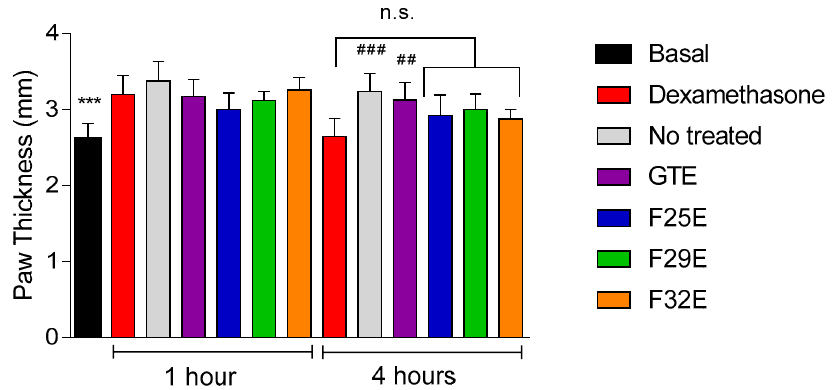
Figure 7. Anti-inflammatory activity of the LCS with green tea extract at 300 mg·g − 1 (F25E, F29E, and F32E), dexamethasone (positive control—cream containing dexamethasone at 1 mg·g − 1 ), and negative control. Notes: the data are represented as mean ± standard deviation of results from five mice. The statistical significance of paw thickness was analyzed using variance analysis via Dunnett’s multiple comparison test; *** p ≤ 0.001. vs. Dexamethasone at 1 h of experiment. ## p ≤ 0.01 vs. Dexamethasone at 4 h of experiment. ### p < 0.001 vs. Dexamethasone at 4 h of experiment. n.s.: no significant difference vs. Dexamethasone at 4 h of experiment.